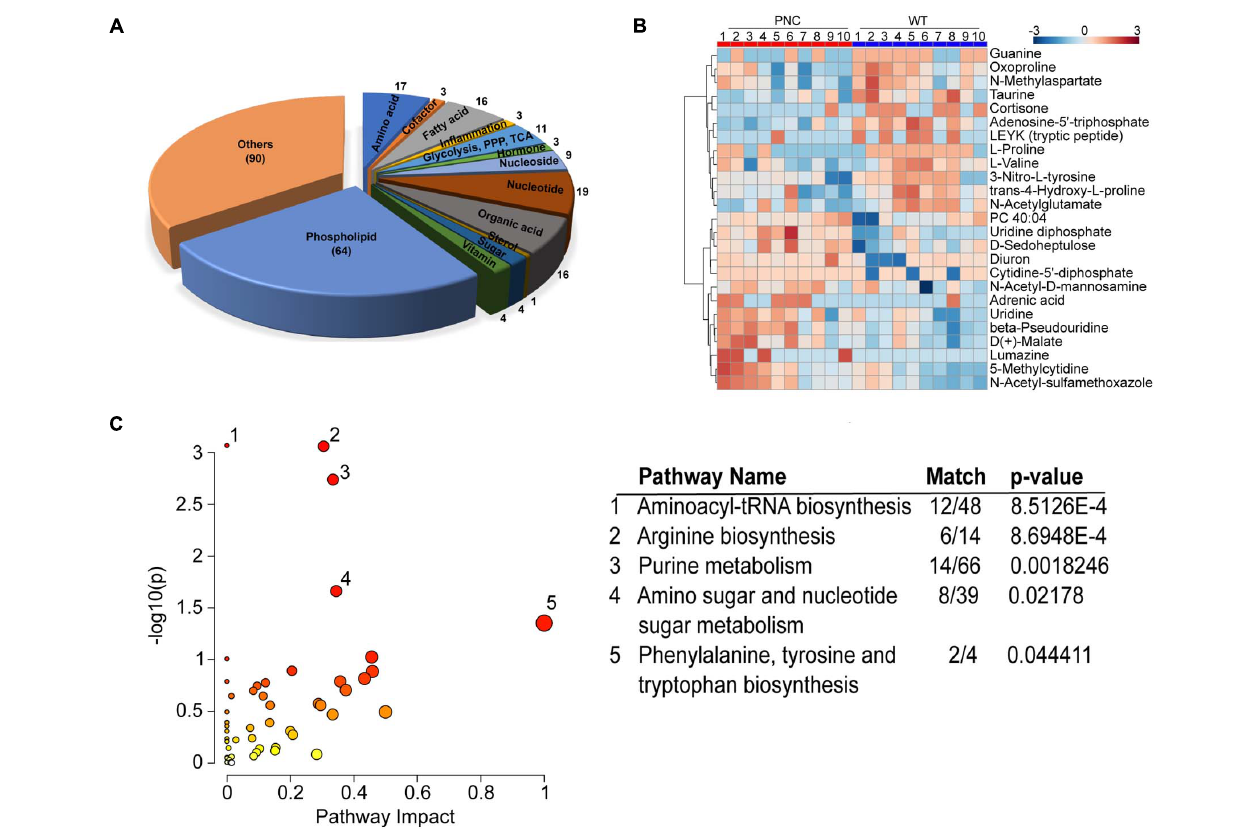
FIGURE 3 | Metabolites extracted from zebrafish larval skin tissue. (A) Two-dimensional pie chart showing the distribution of 260 annotated metabolites assigned into compound classes using ClassyFire. The metabolites in each class are represented in the wedges and indicated with a number. (B) Heatmap generated using MetaboAnalyst 5.0 online platform showing the preneoplastic cell (PNC) and control (WT) groups for N = 10. The normalized relative abundance is presented in a gradient from blue (low) to red (high). (C) Scatter plot of Danio rerio KEGG metabolic pathways identified in the metabolomics dataset. The p -values from the pathway enrichment analysis are shown in darker color indicating more significant changes within a pathway, while the pathway impact values from the pathway topology analysis are depicted by the size of the node. Significantly ( p < 0.05) impacted pathways are numbered and tabulated: 1, Aminoacyl-tRNA biosynthesis; 2, Arginine biosynthesis; 3, Purine metabolism; 4, Amino sugar and nucleotide sugar metabolism; 5, Phenylalanine, tyrosine and tryptophan biosynthesis. The match column shows the number of metabolites identified within the KEGG pathway.